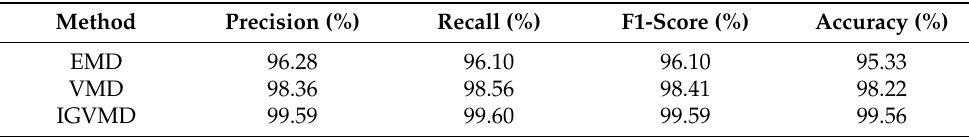
Table 5. The diagnosis result evaluation of different methods.